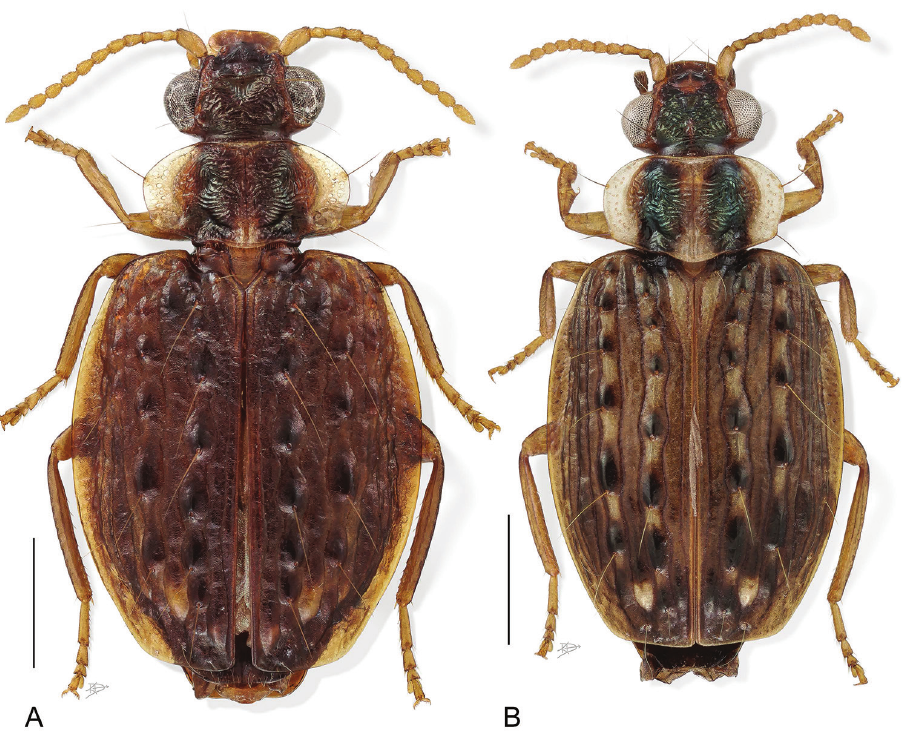
Figure 9. Digital Photo-illustration. Habitus, dorsal aspect. A Hyboptera tuberculata (Dejean), female, ADP007533 B Hyboptera verrucosa (Reiche), female,